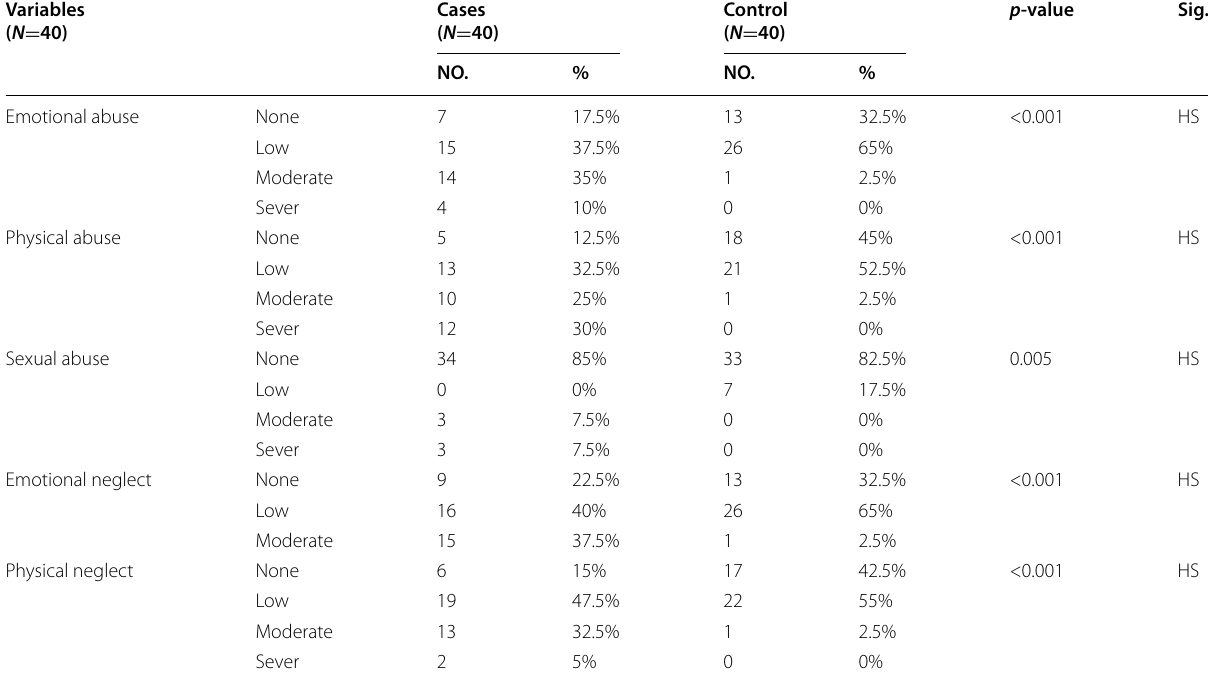
Table 3 Comparisons of Childhood Trauma Questionnaire (CTQ) in different study groups Variables ( N 40) =